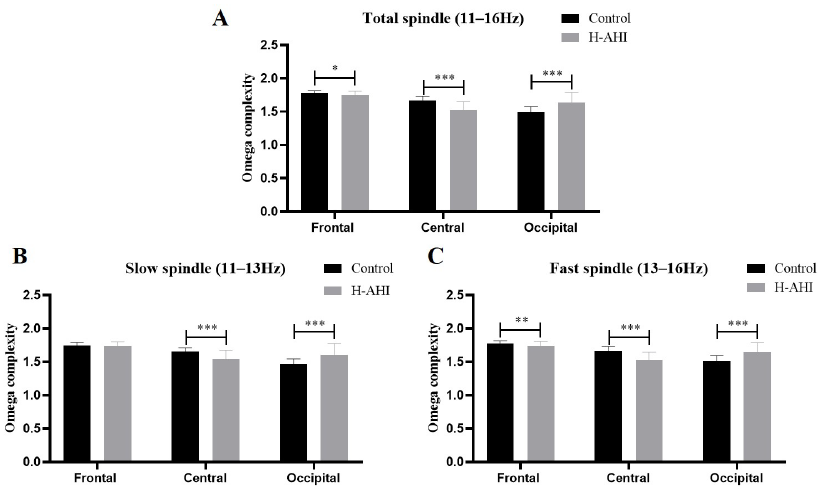
Figure 2. Omega complexity of sleep spindle results. ( A ) Total spindle; ( B ) Slow spindle; ( C ) Fast spindle. Note: *, p < 0.05; **, p < 0.01; ***, p < 0.001.